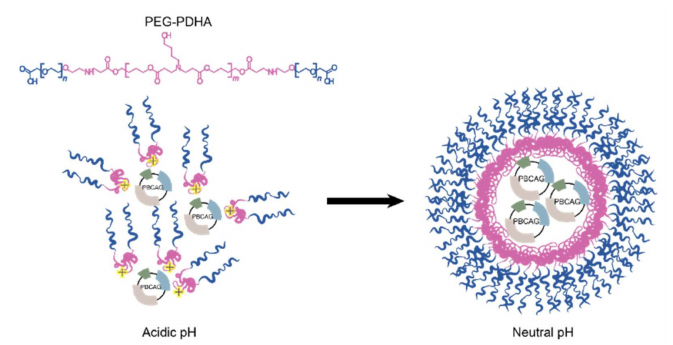
Figure 1. Schematic representation of the gene-editing tool piggyBac transposon (PBCAG) plasmid encapsulation through complexation with amine groups in the poly (1,4-butanediol)–diacrylate- β – hydroxyamylamine) (PDHA) polymer